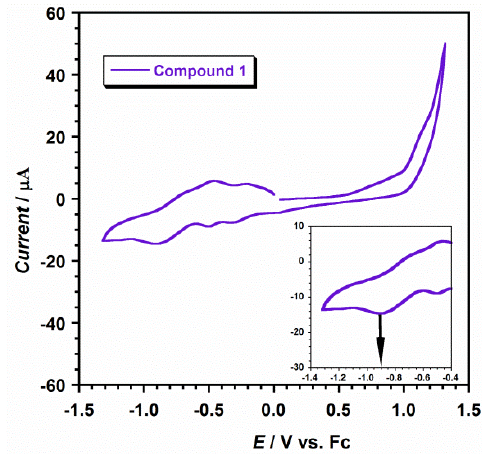
Figure 7. Cyclic voltammogram of 1 in a dry DMF 10 − 3 M solution (with 0.1 M [NBu 4 ][PF 6 ]) at 20 °C and scan rate 200 mV/s. The area of the working electrode is 0.32 cm 2 .